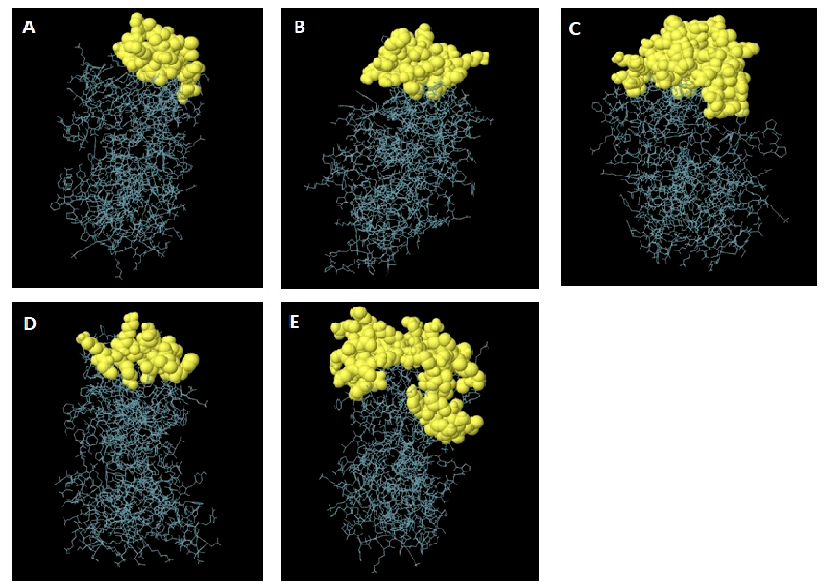
Figure 4. Discontinuous B cell epitopes in the 3D model of the designed construct. ( A – E ) The grey sticks represent the bulk of the peptide construct and the yellow surfaces depict the residues of discontinuous B cell epitopes.